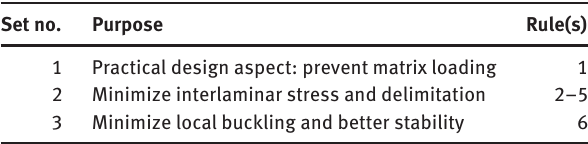
Table 1 Categorization of selected rules. Set